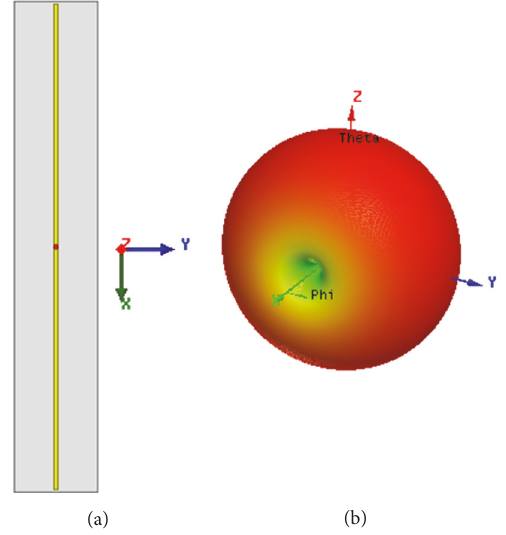
Figure 4: Dipole antenna: (a) form and (b) radiation pattern.